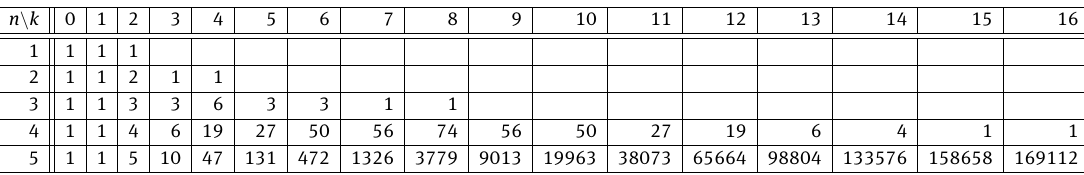
Table 13: Number of 0/1 -polytopes in I n with 0 ≤ k ≤ 2 n vertices for n ≤ 5 .